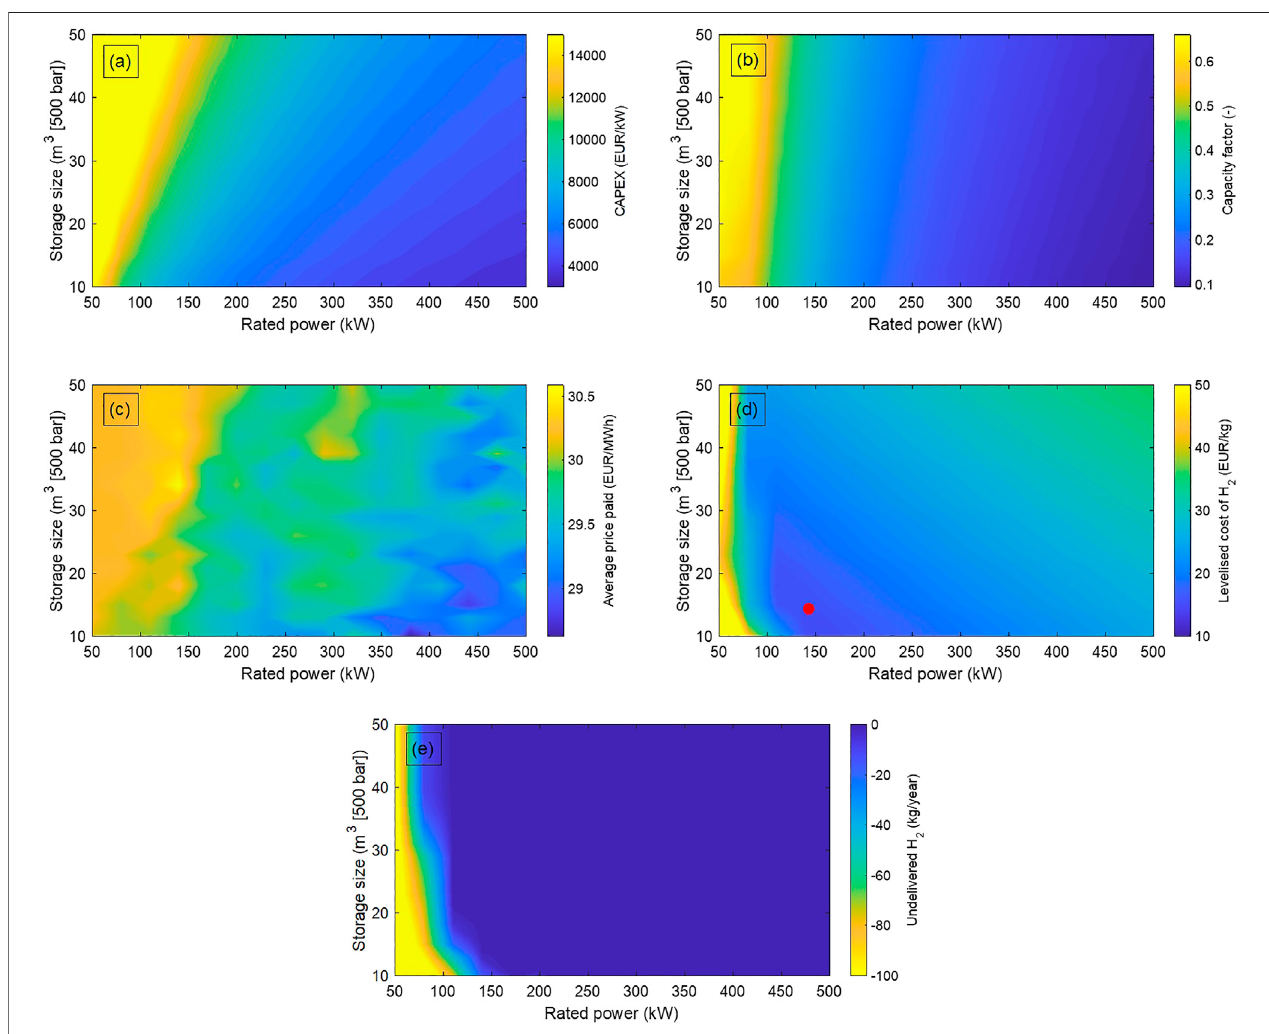
FIGURE6| Resultsofelectrolyserandstoragecapacityoptimizationforcase2bin2020. (A) speci fi ccapitalexpenditures(CAPEX); (B) capacityfactor; (C) average price paid for the electricity; (D) levelized cost of H 2 (LCOH 2 ); (E) H 2 delivery check. Note: Red dot shows the optimal plant con fi guration to minimize LCOH 2 .